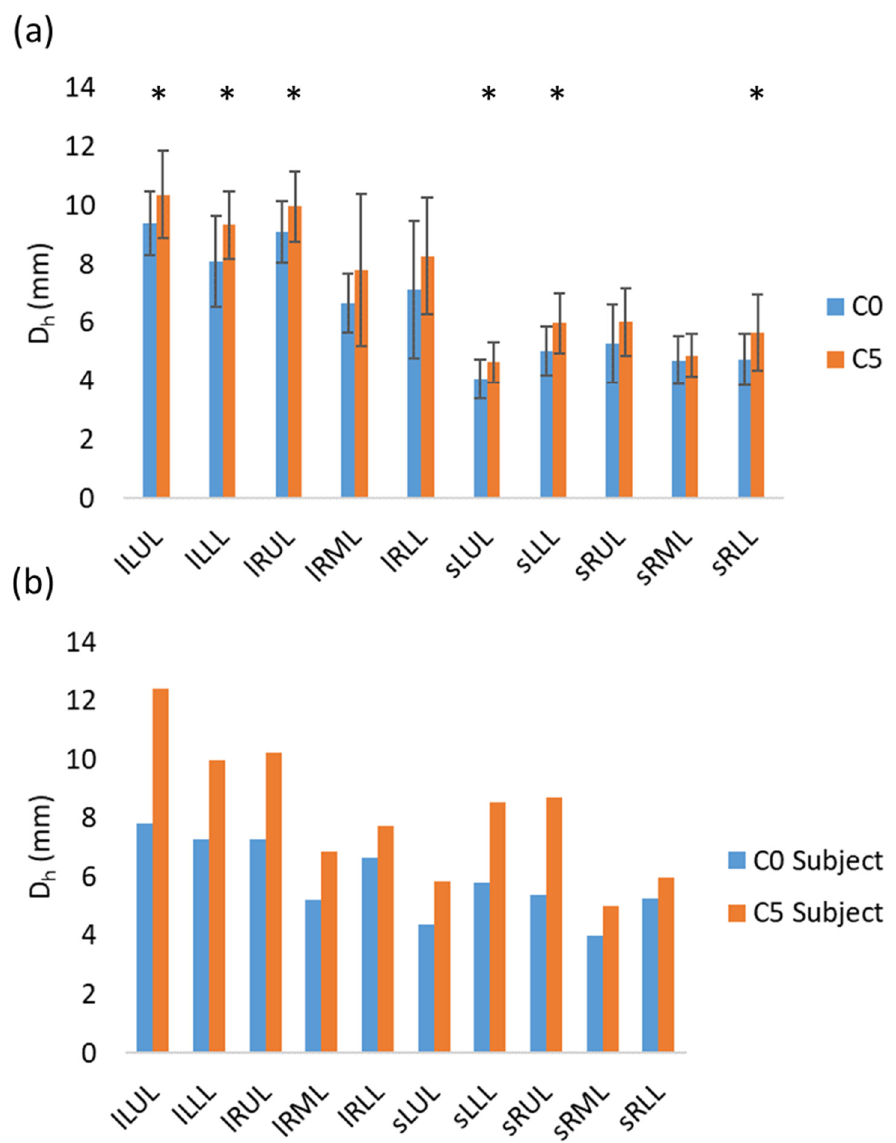
Figure 8. ( a ) Averaged hydraulic diameters of the lobar airways and segmental airways of C0 and C5. A “*” denotes a significant difference between C0 and C5. The differences between the means of independent groups were analyzed by Welch’s ANOVA with the Games–Howell method for post hoc pairwise tests and the significance level was set as 0.05. ( b ) Hydraulic diameters of the lobar airways and sub-lobar subset airways of the C0 and C5 representative subjects. A lobar airway and a sub-lobar subset airway in a lobe are denoted as “l” followed by the abbreviation of the given lobe (e.g., lRUL) and “s” followed by the abbreviation of the given lobe (e.g., sRUL), respectively.